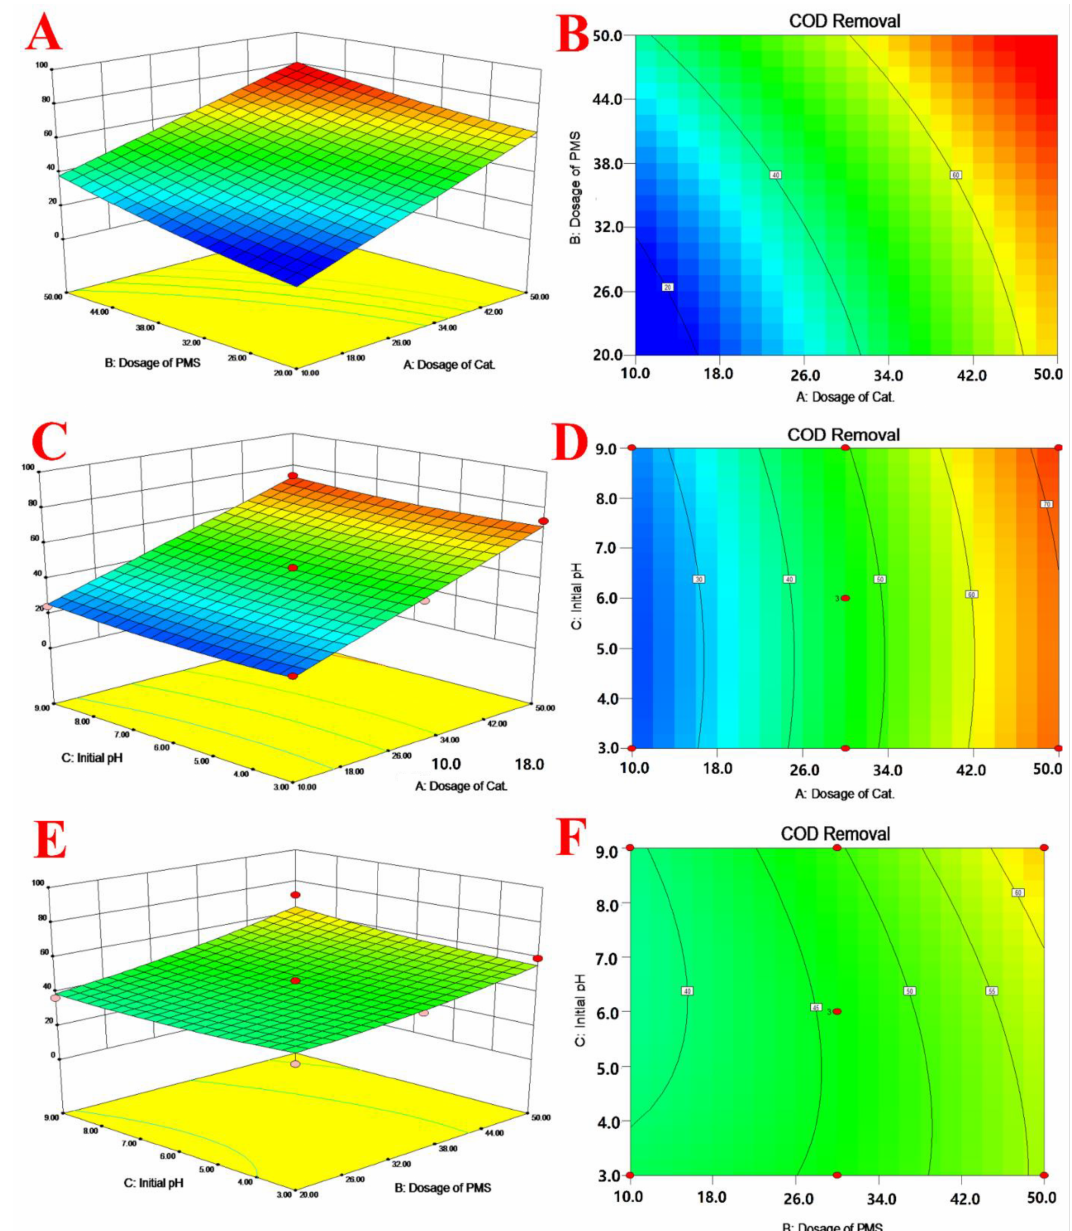
Figure 5. 3D response surface contour of COD removal between the dosage of Cat. and the dosage of PMS ( A ), the dosage of Cat. and initial pH ( C ), the dosage of PMS and initial pH ( E ) and the corresponding contour maps ( B , D , F